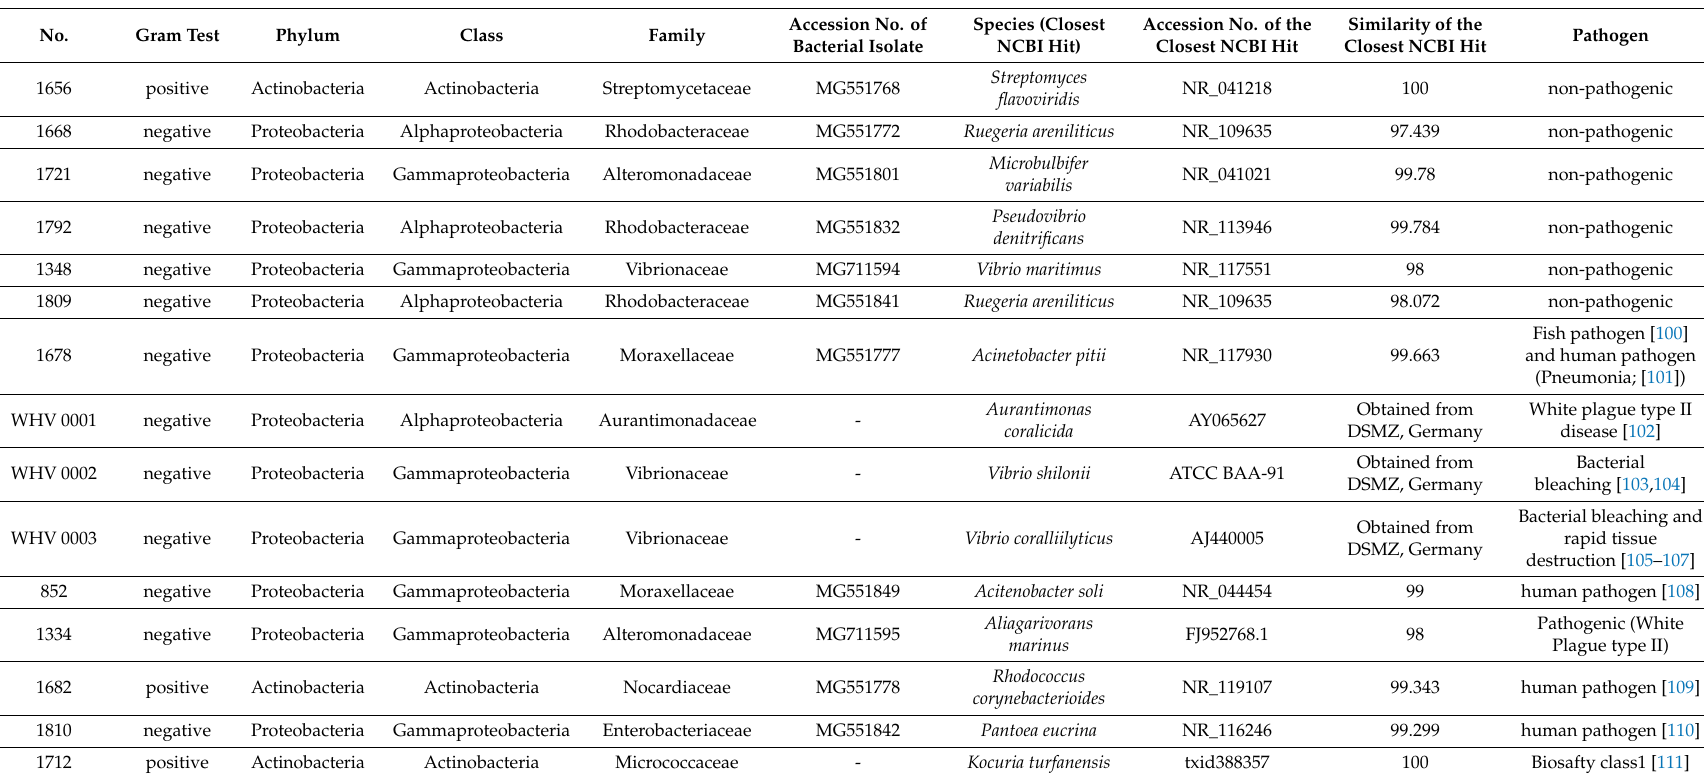
Table 2. List of pathogenic and non-pathogenic test panel of bacteria used for Agar di ff usion assay